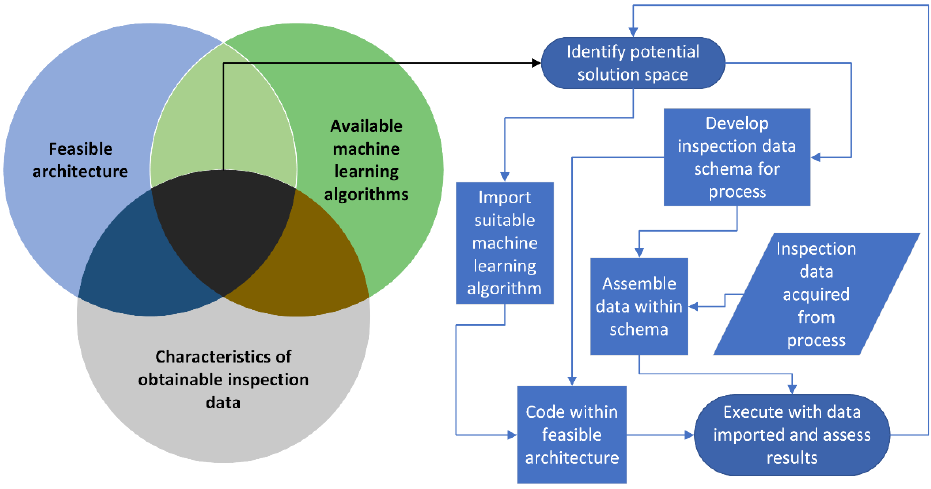
Figure 1. High-level schematic of the method to generate LeMIIIRC, modified from [20].